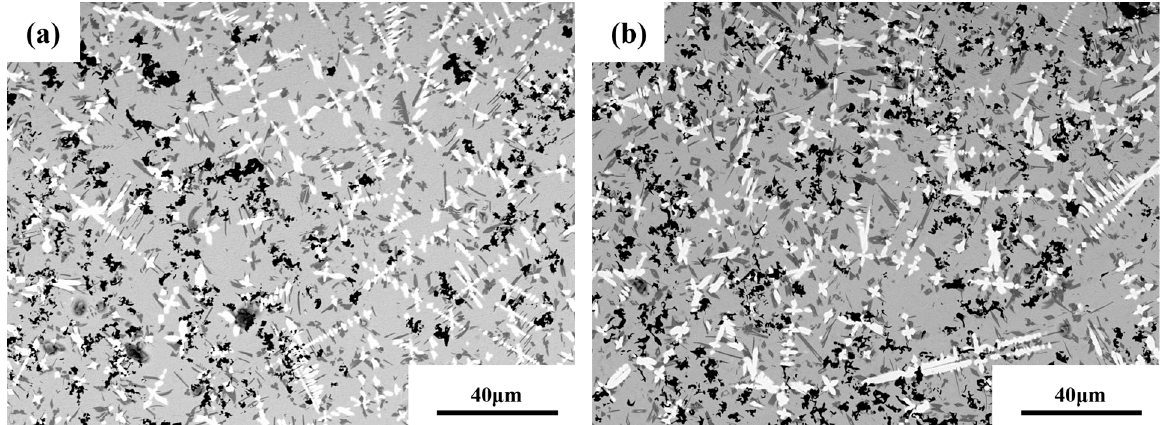
Figure 14. Microstructure at the coating top ( a ) with and ( b ) without ultrasonic vibrations (UP = 800 W, F = 32 kHz).